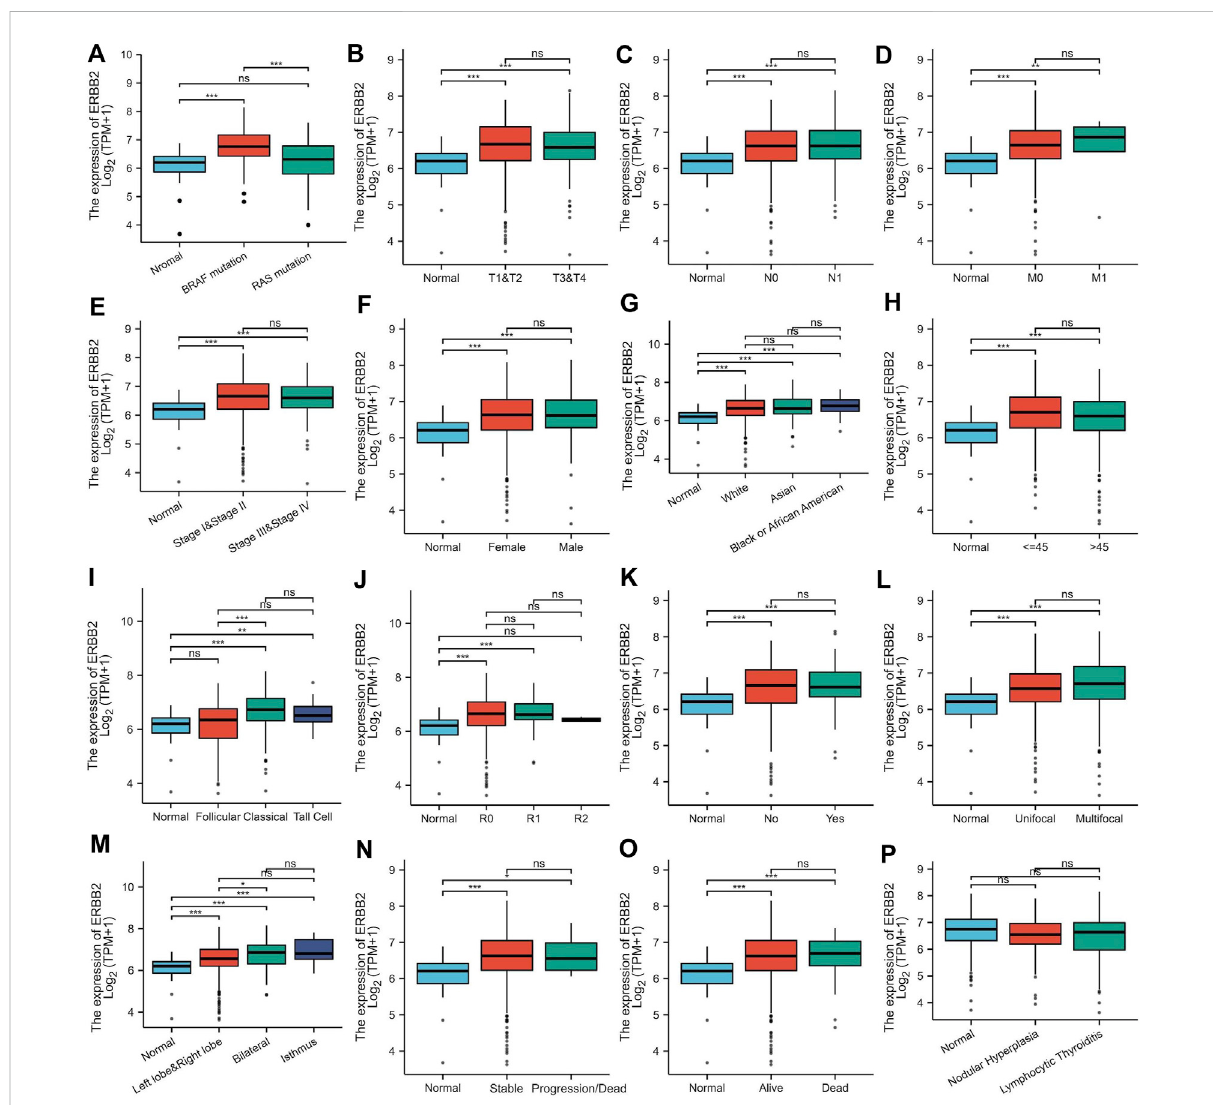
FIGURE 2 ERBB2 expression in papillary thyroid cancer classi fi ed by characteristics: (A) mutation, (B) T stage, (C) N stage, (D) M stage, (E) pathological stage, (F) gender, (G) race, (H) age, (I) histological type, (J) residual tumor, (K) extrathyroidal extension, (L) primary tumor focus type, (M) tumor location, (N) overall survival event, (O) progression-free interval event, and (P) thyroid gland disorder history. * p < 0.05, ** p < 0.01, *** p <